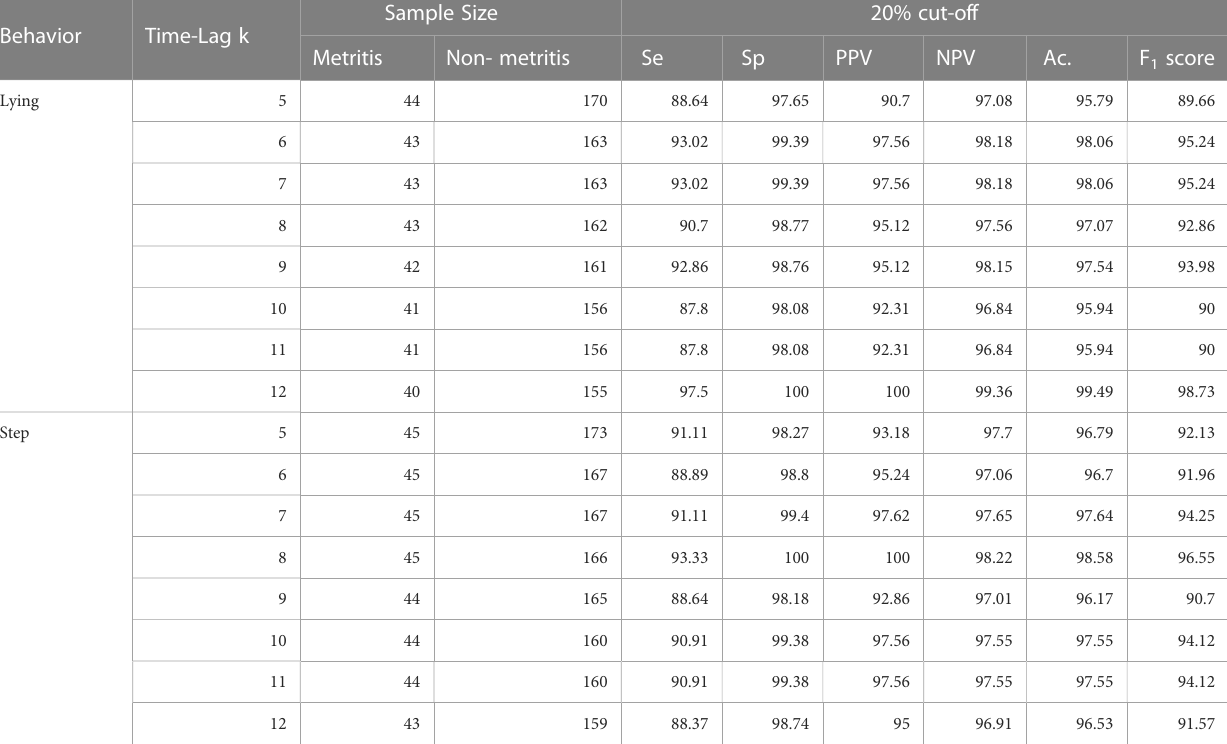
TABLE 3 Results from models ’ performance (%) where random forest (RF) classi fi er was used on sensor data registered by a leg-attached 3-axis accelerometer (TrackaCow, ENGS, Hampshire, UK) from all day were aggregated using a 6-hour time window and the 20% cut-off as decision threshold after ranking the classi fi cation probabilities from high to